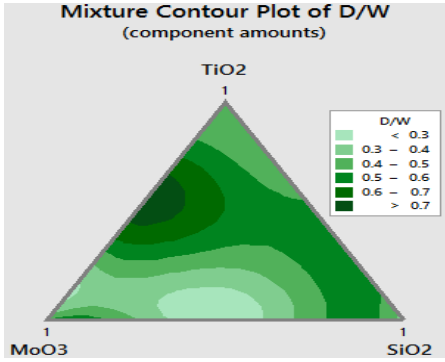
Figure 7. Mixture contour plot of ratio R (D/W).